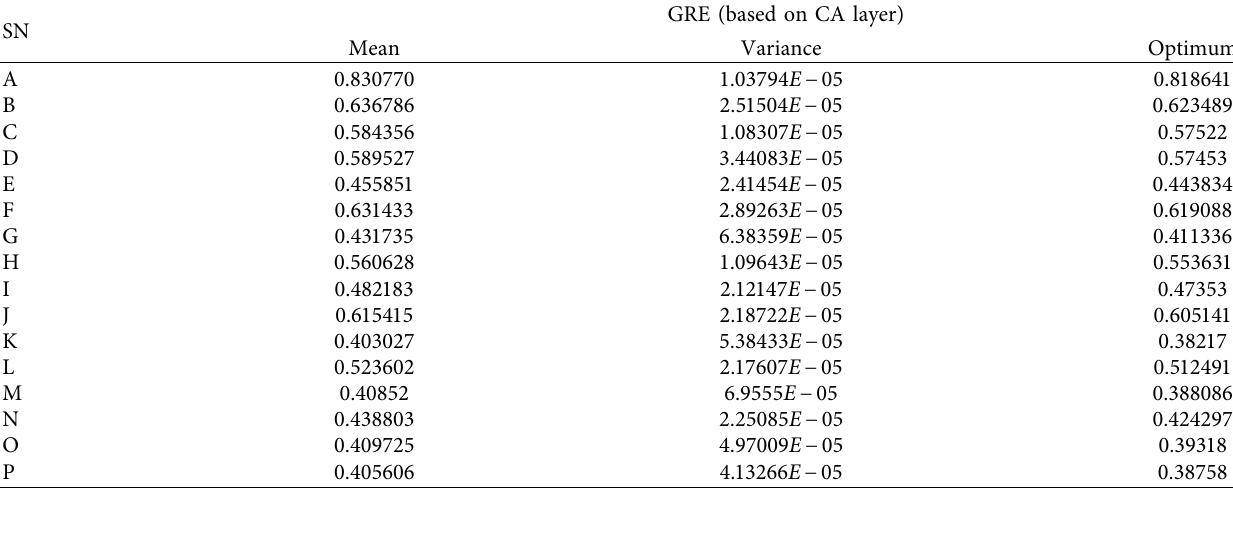
Table 6: Sixteen typical cases of α